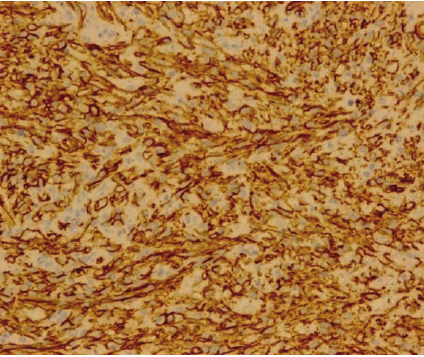
Figure 2: (E.E 100x). Picture that shows a nodular lesion between vascular area in the chorion under the epithelium.